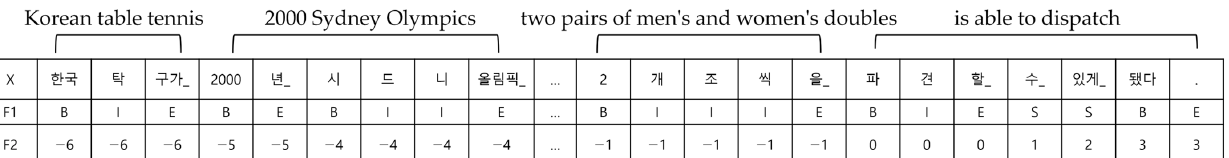
4 of 9 Figure 2. Example of finding an argument-list. 2.3.2. Text Feature